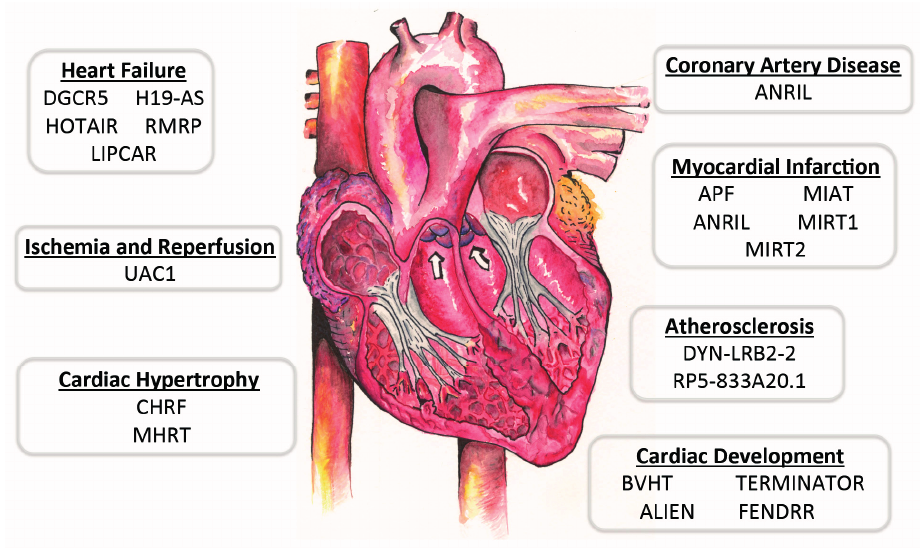
Figure 3. Roles of lncRNAs in cardiovascular development and disease. Overview of lncRNAs discussed in this review is shown. The white arrows show the blood